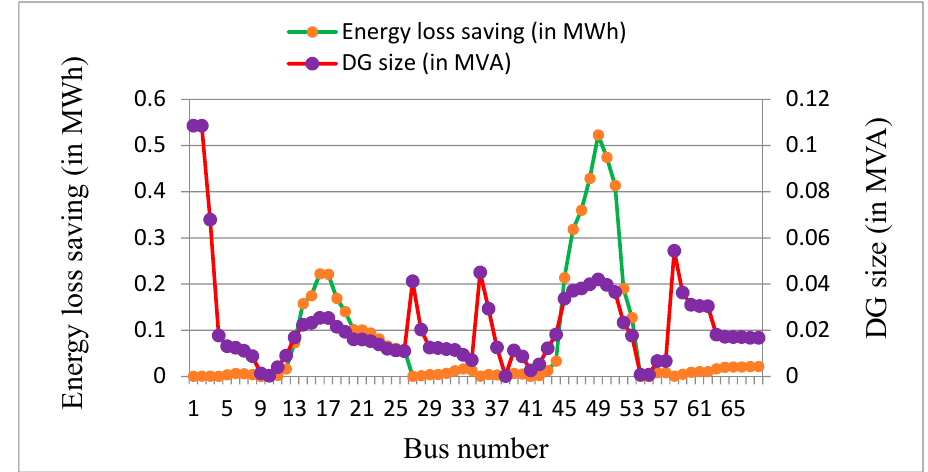
Figure 11. Loss savings of active energy components with subsequent sizes of DGs (in MVA) for different nodes for the fourth iteration with DG placed at nodes 50, 17, 11 and 39 for IEEE 69-bus system.